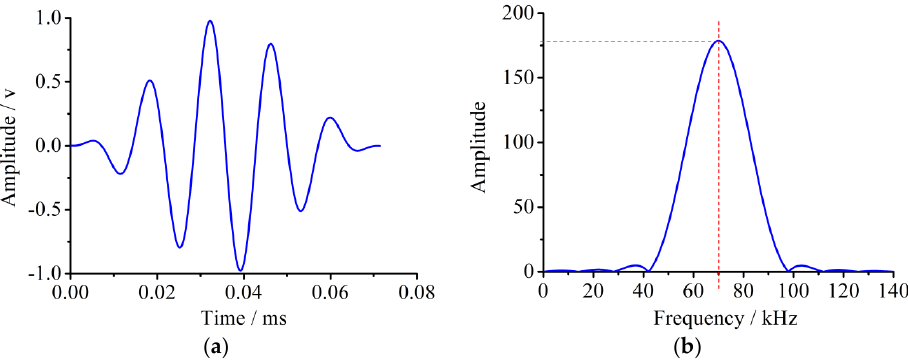
Figure 3. The excitation signal with the central frequency of 70 kHz and amplitude of 5 V. ( a ) The normalized waveform in the time domain; ( b ) The corresponding wave in the frequency domain.